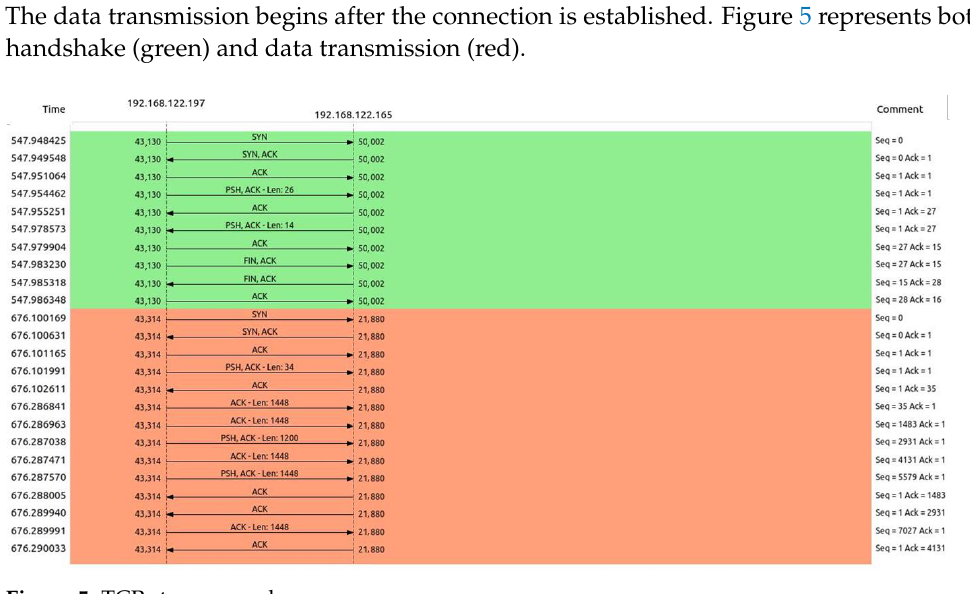
Figure 6. Non-encrypted file RTT.